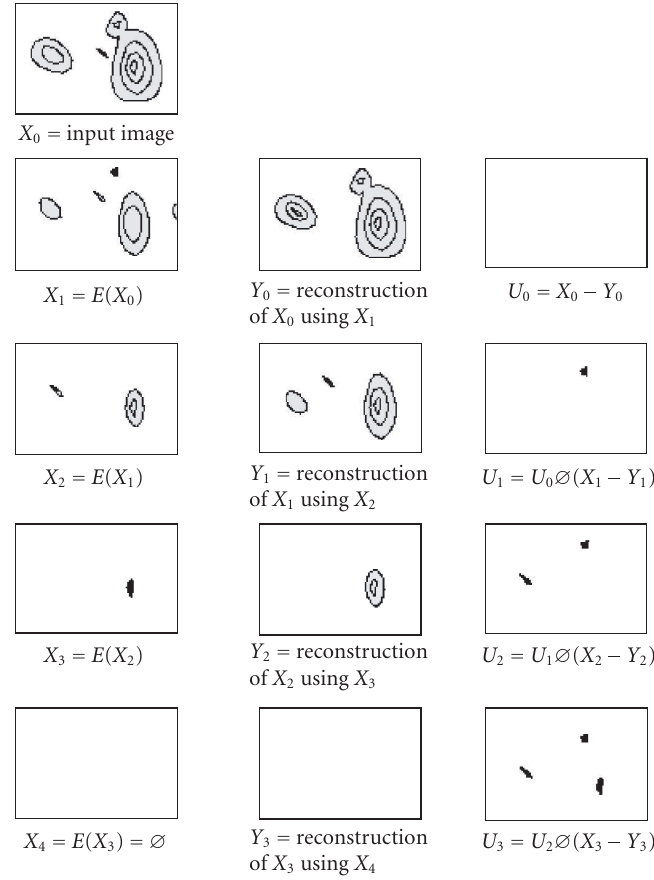
Figure 2.3. An example of the ultimate erosion operation. Ultimate erosion is implemented through the iterative erosion of the image until all objects vanish (images X i ), and the reconstruction of each eroded image using the eroded image, E ( X i ), as the mask and the erosion of smaller size as the marker. The reconstructed images (images Y i ) are subtracted from the corresponding eroded images to form the eroded sets (images U i ). The final resultant image is known as the ultimate erode set. (Source: [3].) When a particle disappears after an erosion, it is not reconstructed and thus appears in image U i